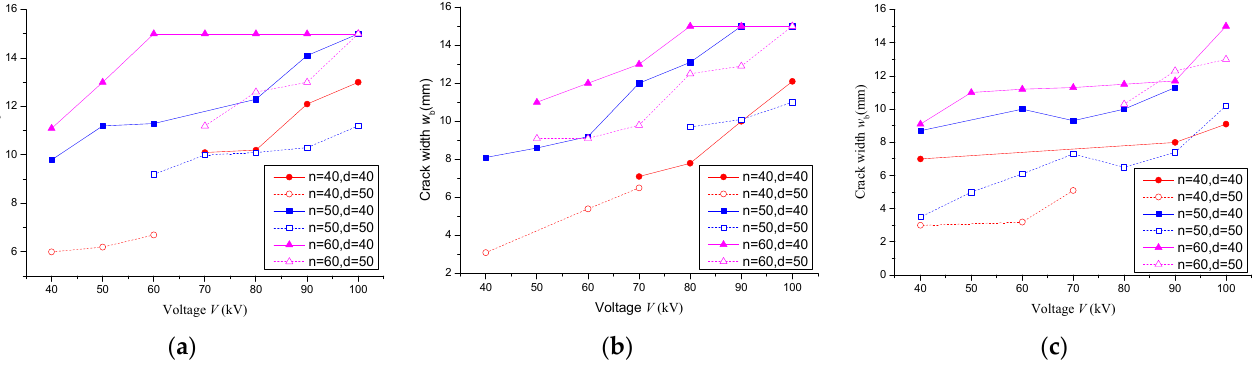
Figure 10. The relationship between crack width and hole diameter. ( a ) Concrete C20; ( b ) Concrete C30; ( c ) Concrete C40.